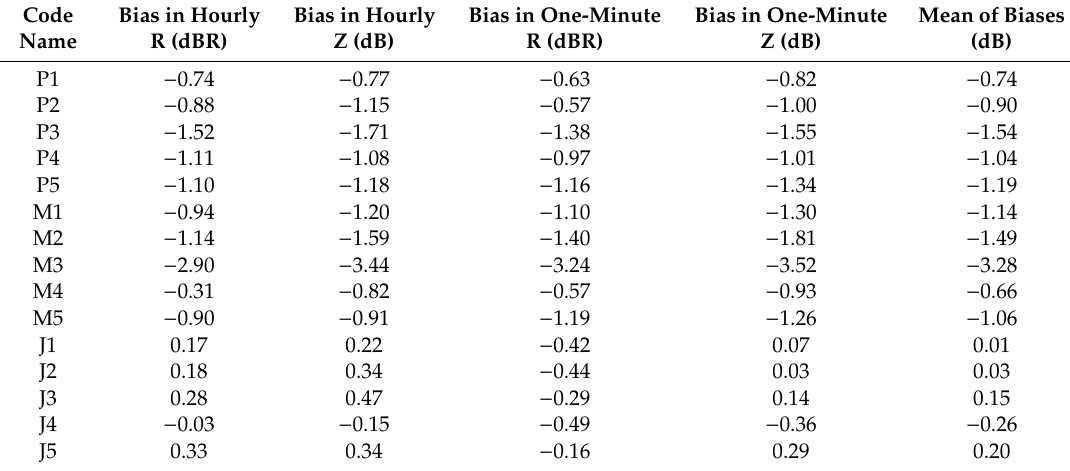
Table 4. Bias values and their mean for each disdrometer calculated from hourly and one-minute rainfall rate and reflectivity.